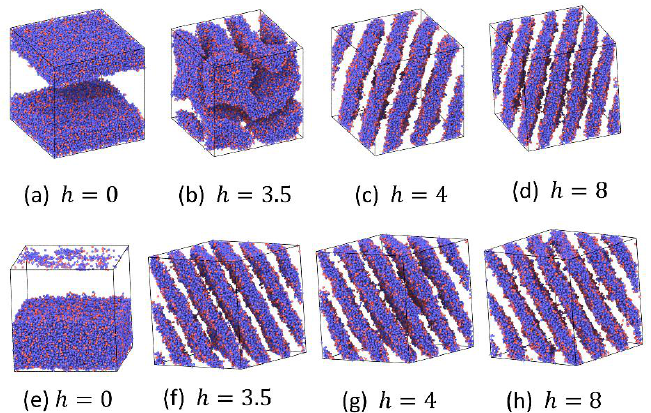
Figure 4. ( a ) The averaged order parameter, O 2 , and ( b ) the normalized extent of reaction, ξ ∗ , as a function of the reversible bond strength, h , for system A5B5. LAM denotes a lamellar phase, 2 Φ -LAM denotes a coexistent phase and 2 Φ denotes a two-phase state.